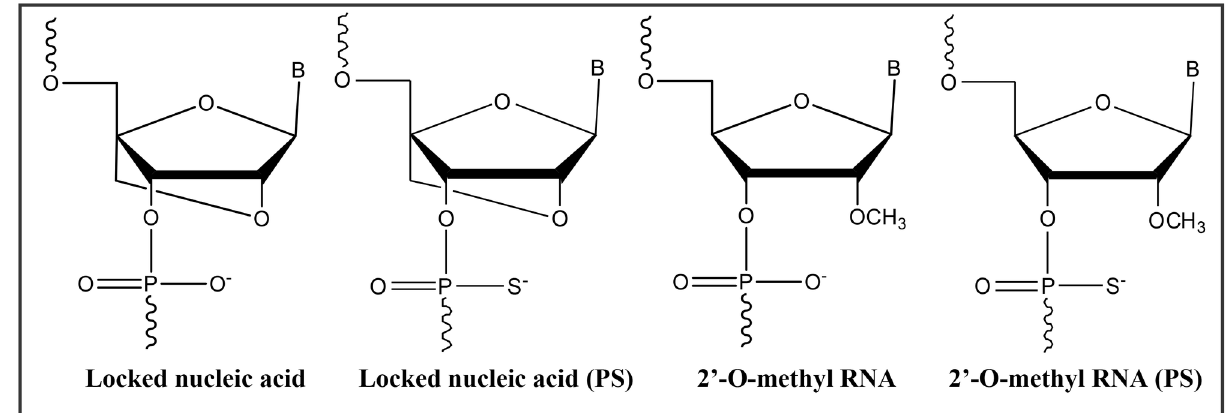
Figure 1. Structures of LNA and 2’ O-methyl RNA monomers (phosphate and phosphorothioate structures) used. doi: